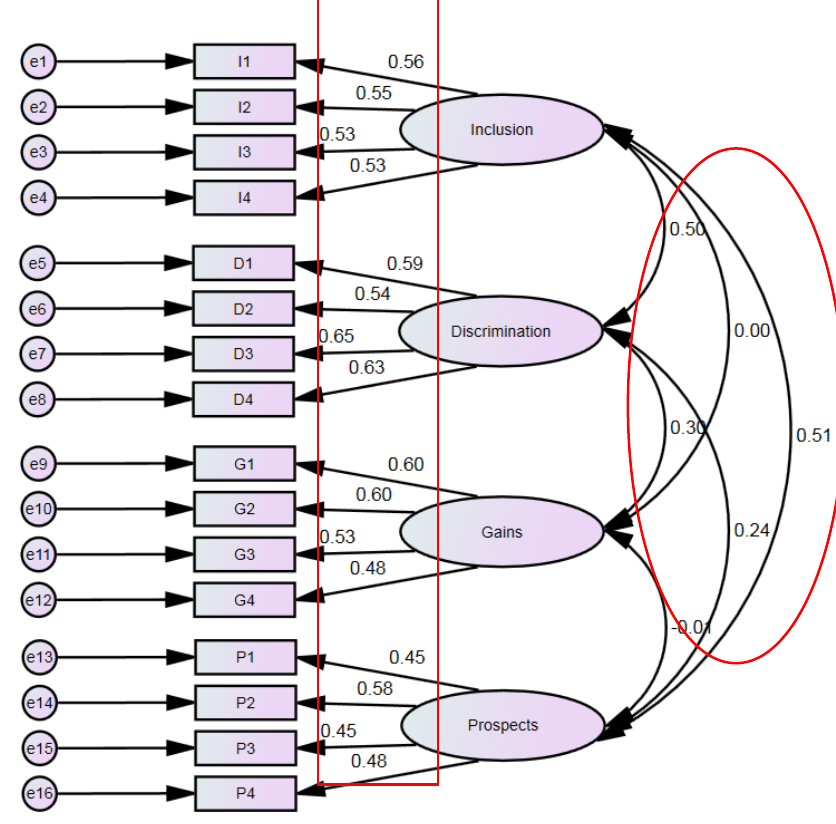
Figure 1. Results of the confirmatory factor analysis model—standardized estimates (ML method). Variable content—see [22]. Table 3. Four-factor model: parameter estimates and